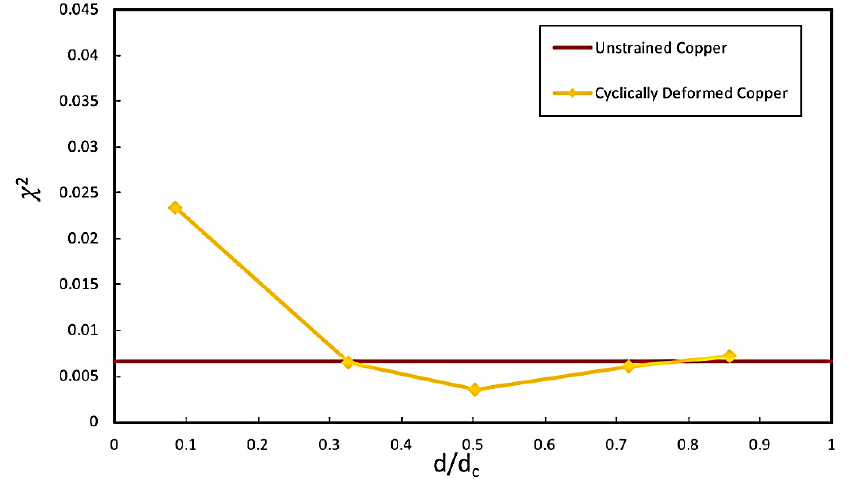
Figure 6. Change in the [411] CBED pattern higher order Laue zone (HOLZ) lines of cyclically deformed copper in a channel (and near the walls) and undeformed copper relative to simulated pattern with lattice parameter of 0.35920 nm. The data is shown as a χ 2 analysis fit between the HOLZ lines of the aforementioned CBED patterns.